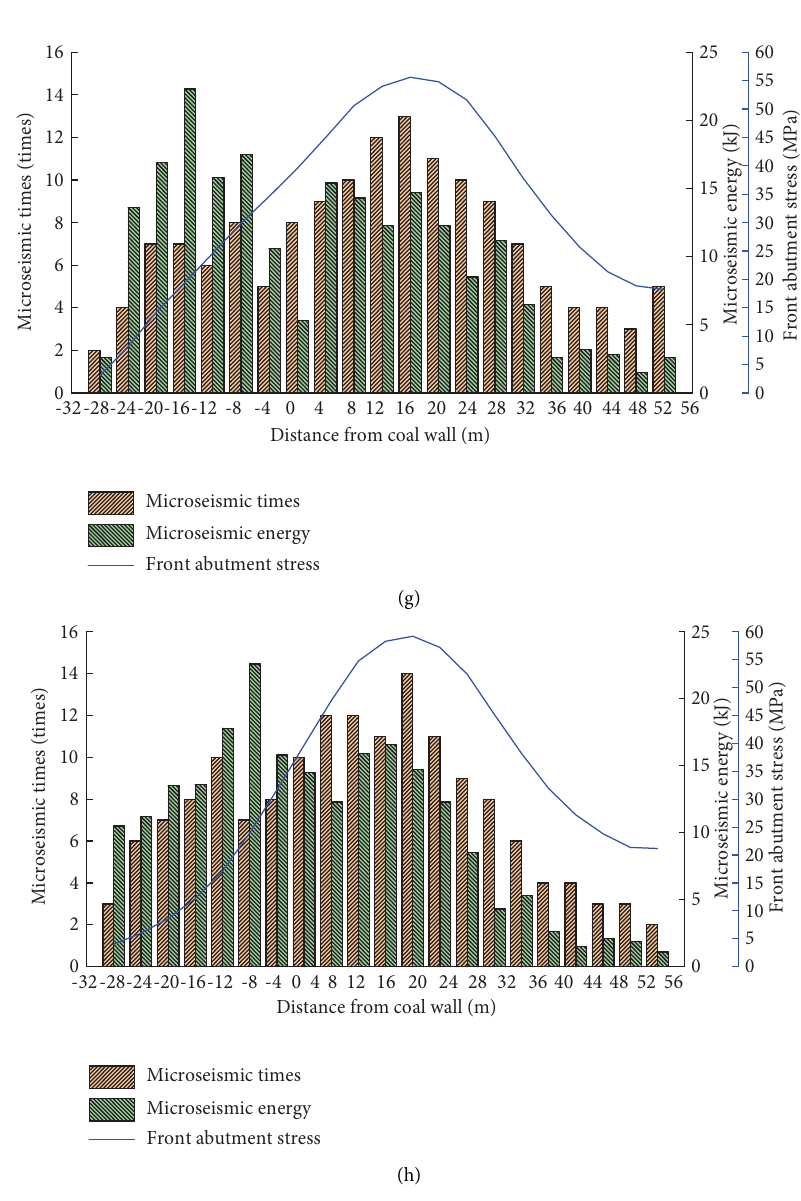
Figure 5: Relationship between microseismic frequency, energy, and support pressure. (a) Caving 50m. (b) Caving 100m. (c) Caving 150m. (d) Caving 200m. (e) Caving 250m. (f) Caving 300 m. (g) Caving 350 m. (h) Caving